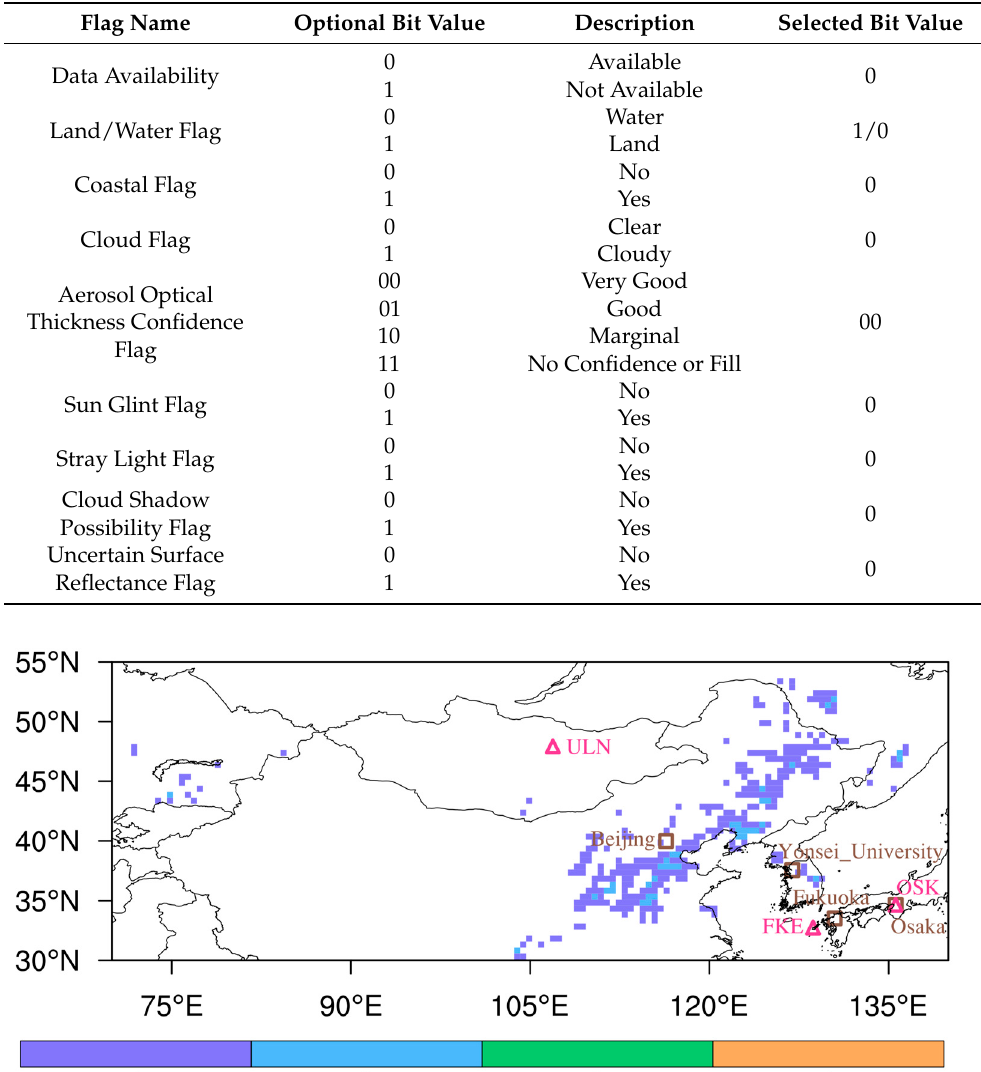
Table 1. Quality assurance flags (QA_Flags) used for the quality control of GCOM-C AOTs.